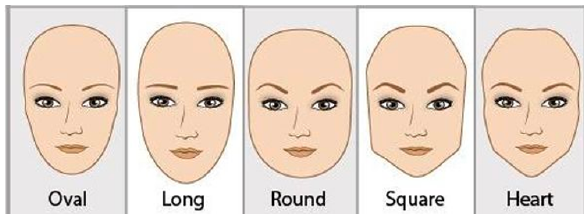
Figure 1. Categories of face shape [38].